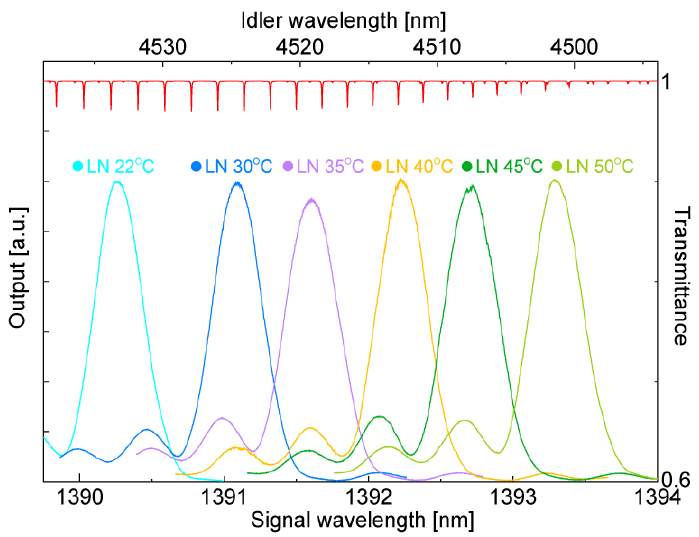
Figure 3. DFG tuning curves at various